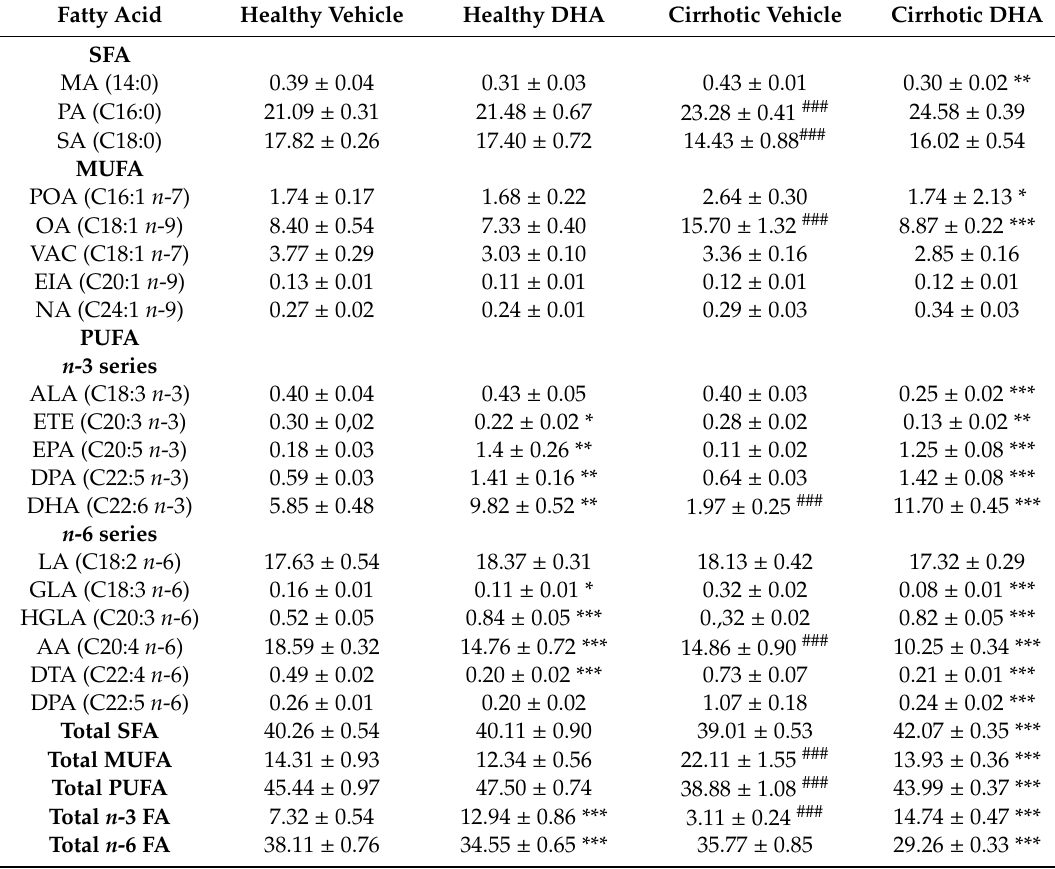
Table 1. E ff ects of docosahexaenoic acid (DHA) administration on hepatic fatty acid composition in healthy and cirrhotic rats.